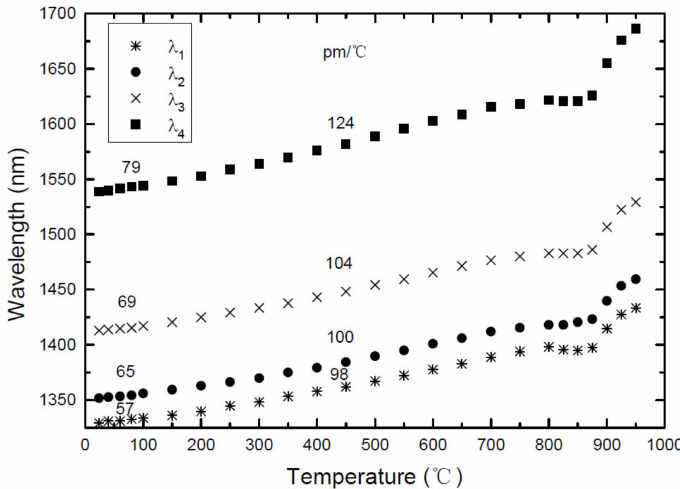
Figure 1. Thermal behavior of a 540 µ m LPFG arc-induced in the Siecor fiber. Reprinted with permission from ref. [85]. © 2021 Taylor and Francis.